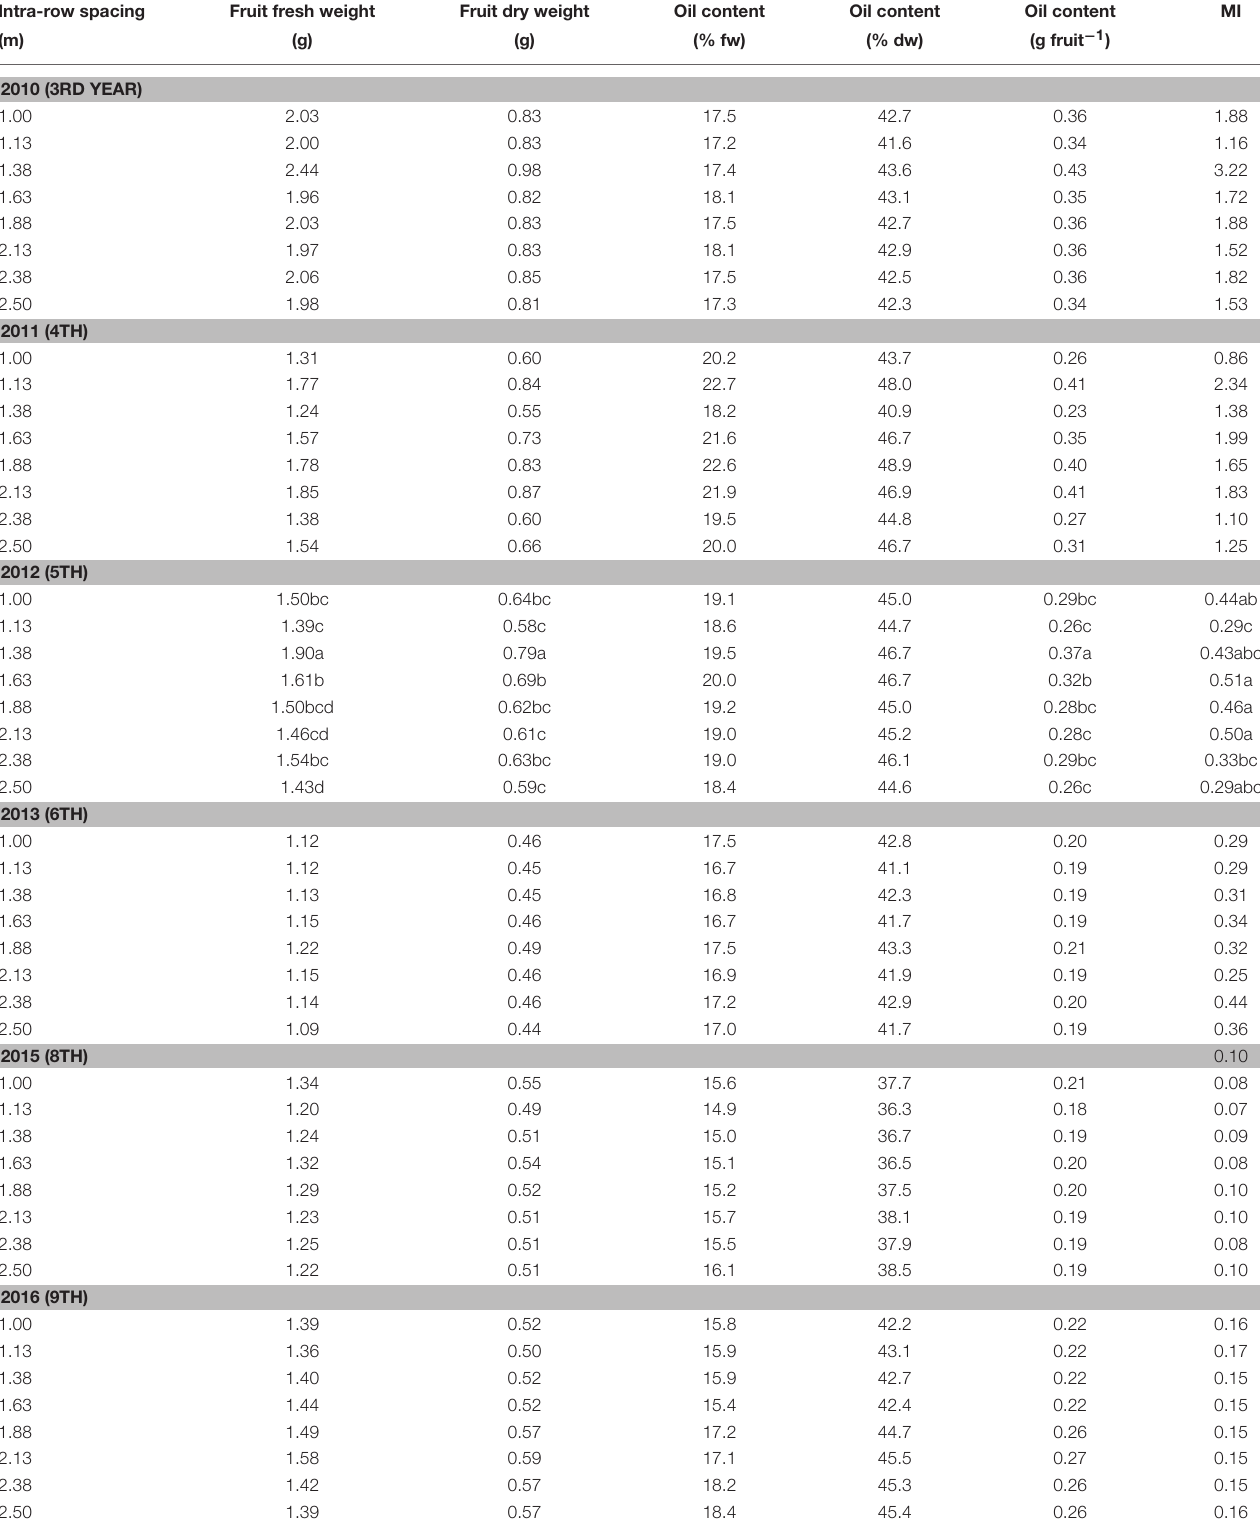
TABLE 3 | Fruit characteristics for the first 6 years of harvest of trees planted at various intra-row spacing. Intra-row spacing Fruit fresh weight Fruit dry weight Oil content Oil content Oil content